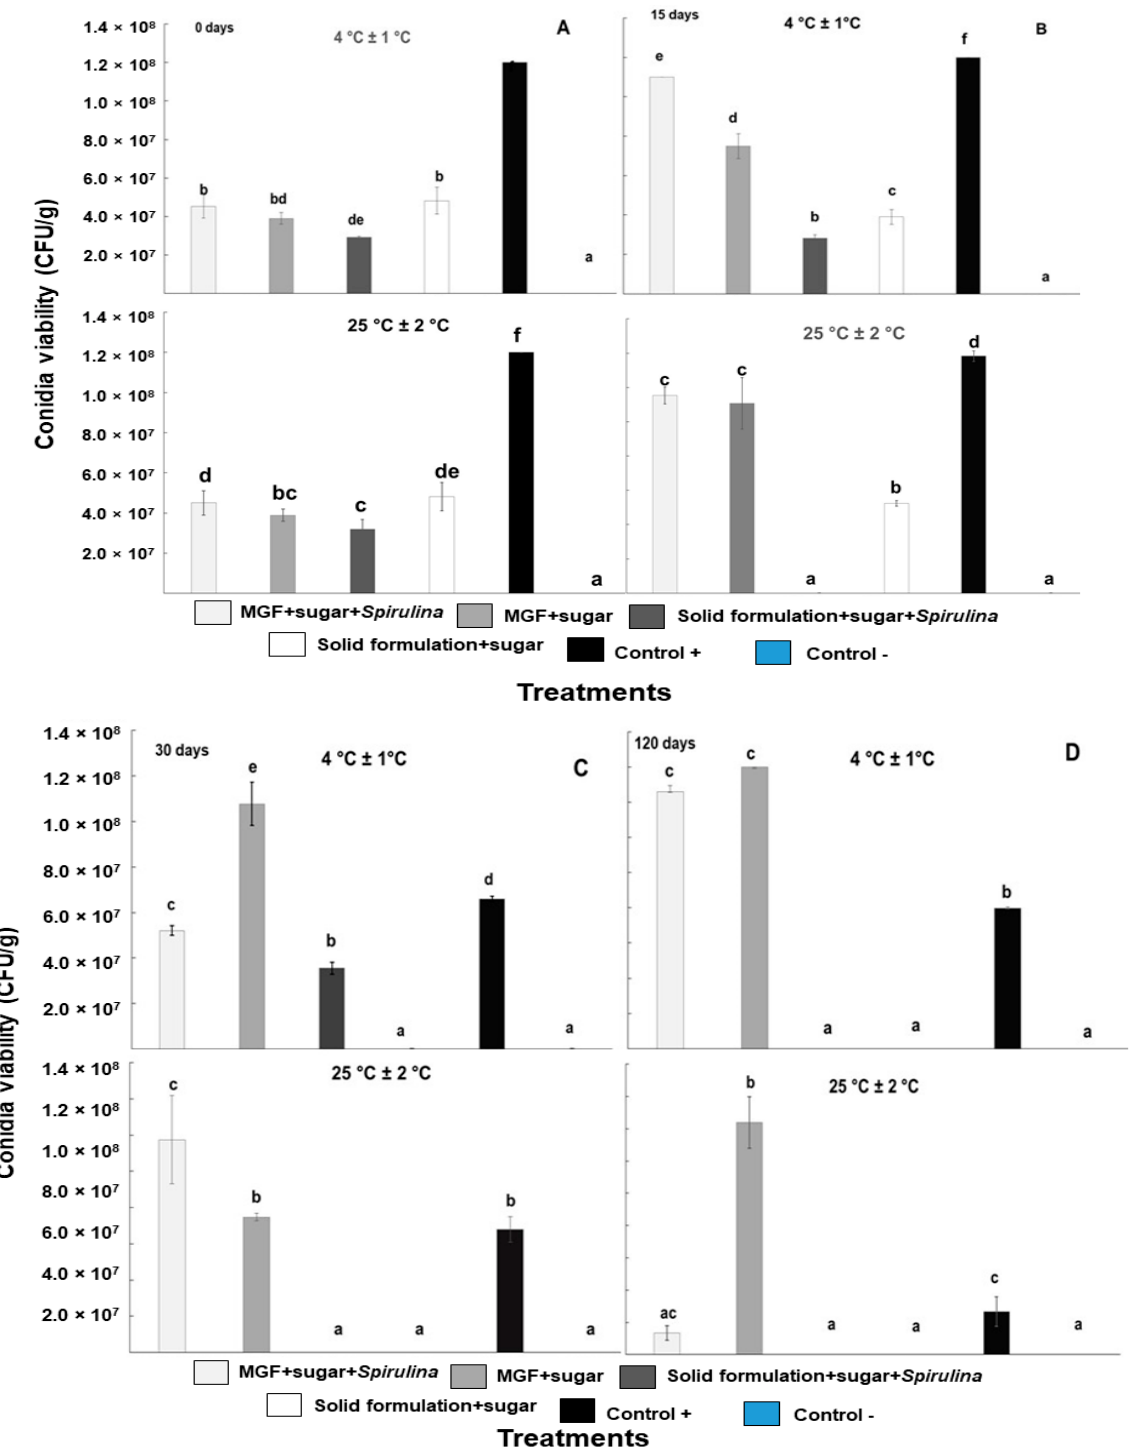
Figure 4. Beauveria bassiana conidia viability in microgranular formulation (MGF) at ( A ) 0 d, ( B ) 15 d, ( C ) 30 d, and ( D ) 120 d in colony forming units per gram (CFU/g). MGFs = MGF plus sugar, FS = solid formulation. Data represent mean + SEM of triplicate determinations from three independent experiments. Same letter between columns indicates that treatments are not significantly different (HSD Tukey test; p > 0.05).